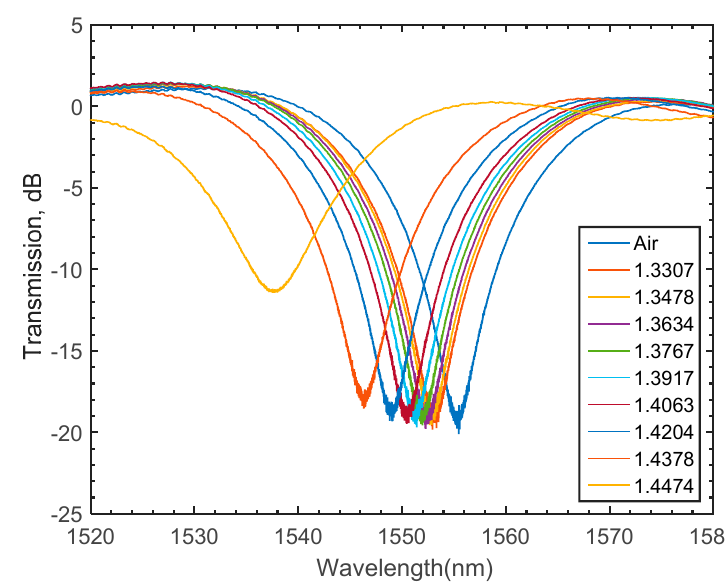
Figure 14. Experimentally obtained shift of the transmission valley when the LPFG is exposed to solutions of different refractive indices.